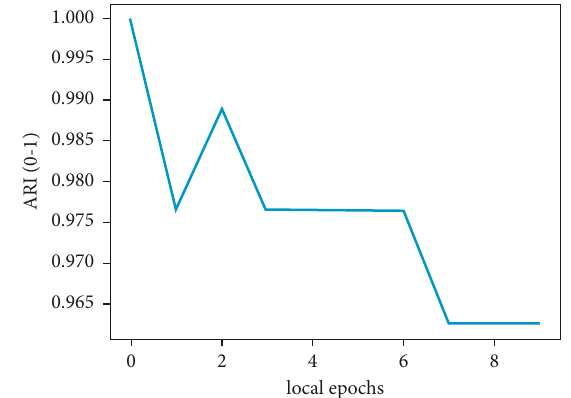
Figure 4: ARI results (data sets � Mnist, min_samples � 2, xi �